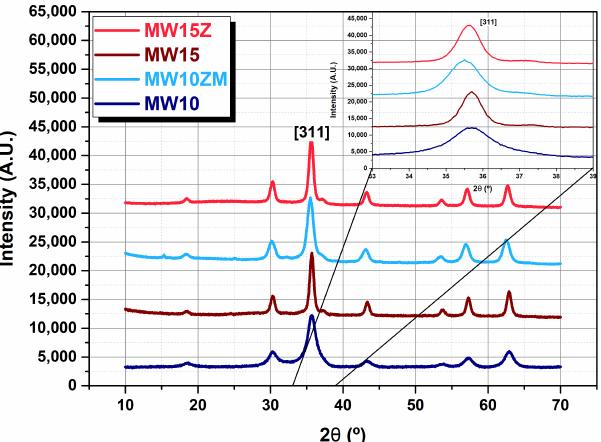
Figure 3. XRD patterns of the samples MW10, MW10ZM, MW15, and MW15Z. Samples MW10 and MW10ZM have smaller dimensions than MW15 and MW15Z.